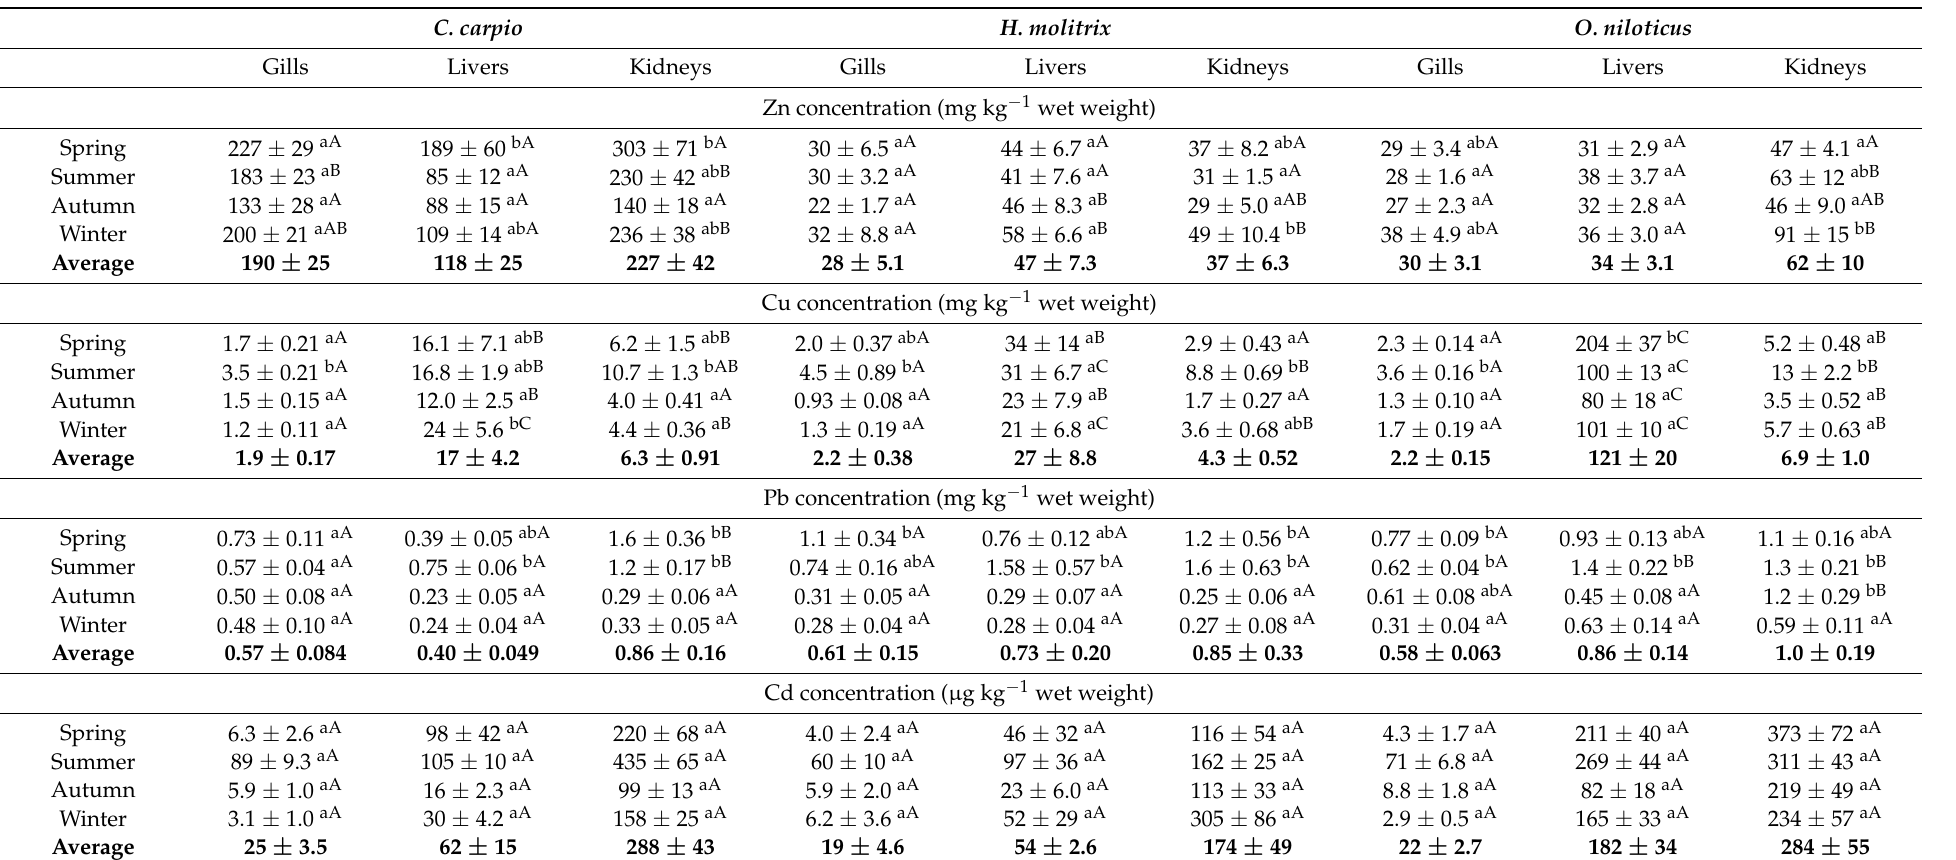
Table 1. Metal concentrations in the gills, livers, and kidneys of C. carpio , H. molitrix , and O. niloticus collected over four seasons. The data are presented as mean ± SEM. Small letters (a > b) represent statistically significant differences between seasons within the same tissue samples from the same species. The capital letters (A > B > C) represent statistically significant differences between tissues of each species within each